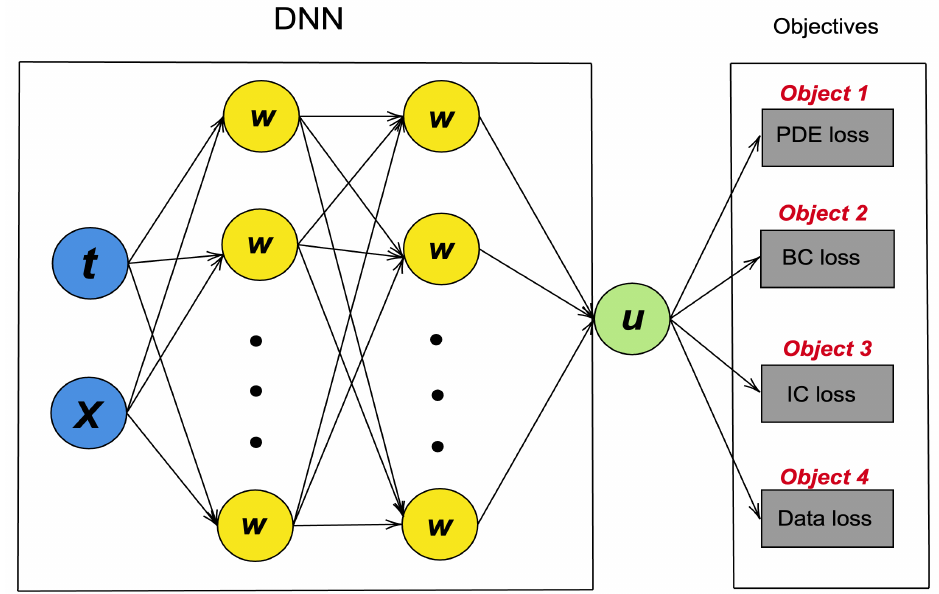
Figure 1. Physical-informed neural network structure